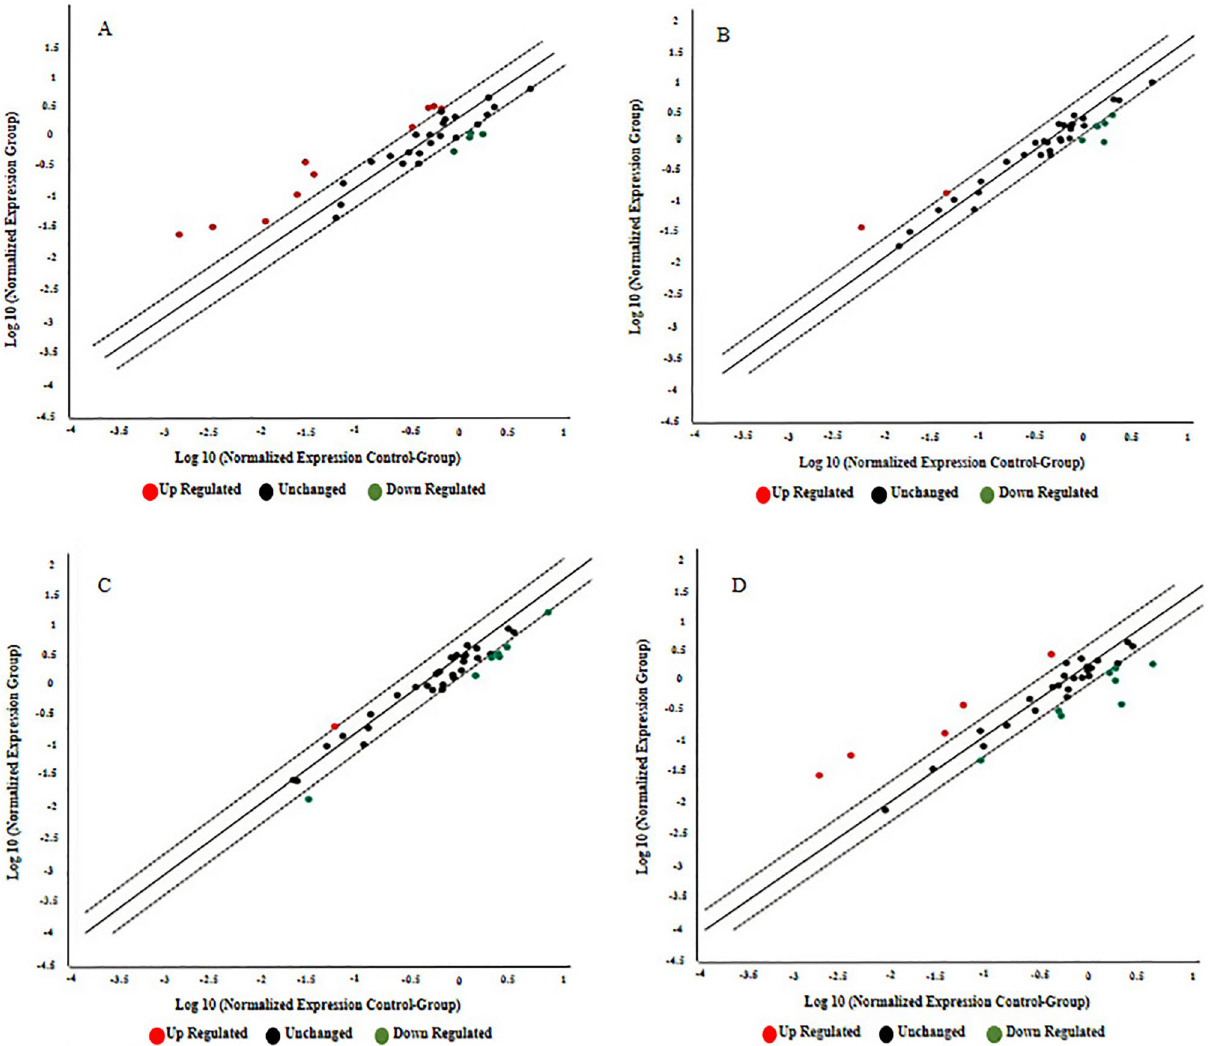
Figure 1. Scatter plot analysis of the relative expression of thirty-seven miRNAs compared between control and GDM patients. ( A ) = first trimester, ( B ) = second trimester ( C ) = third trimester ( D ) = post-partum. Color scheme: red color indicates upregulated miRNAs, while blue indicates downregulated miRNAs. The miRNAs that are significantly altered between the two groups (control and GDM) are located above. The diagonal black line corresponds to P < 0.05. Analysis was performed using online statistical analysis by